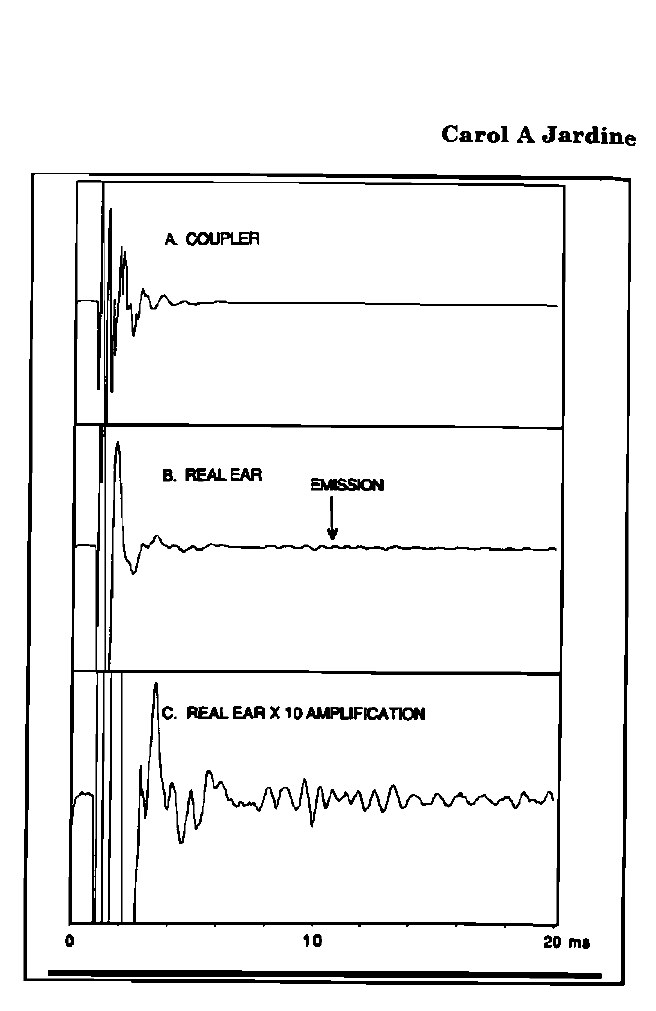
Figure 1. Comparison between responses recorded in a coupler (A) and an adult human ear (B) show- ing the much smaller response at about 6ms post- stimulus amplified in (C) (after Glattke & Kujawa, 1991, p.